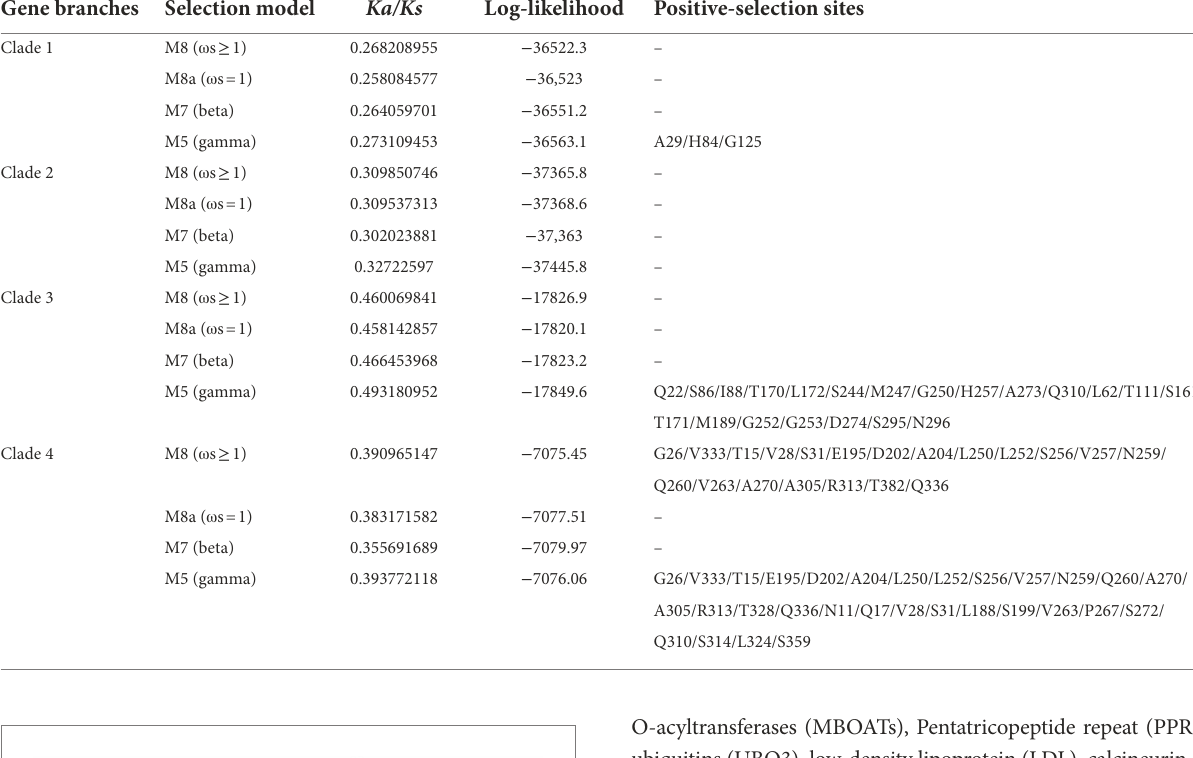
TABLE 1 Likelihood values and parameter estimates of positive selection in codons of SHI/STY gene family in 21 land plants.